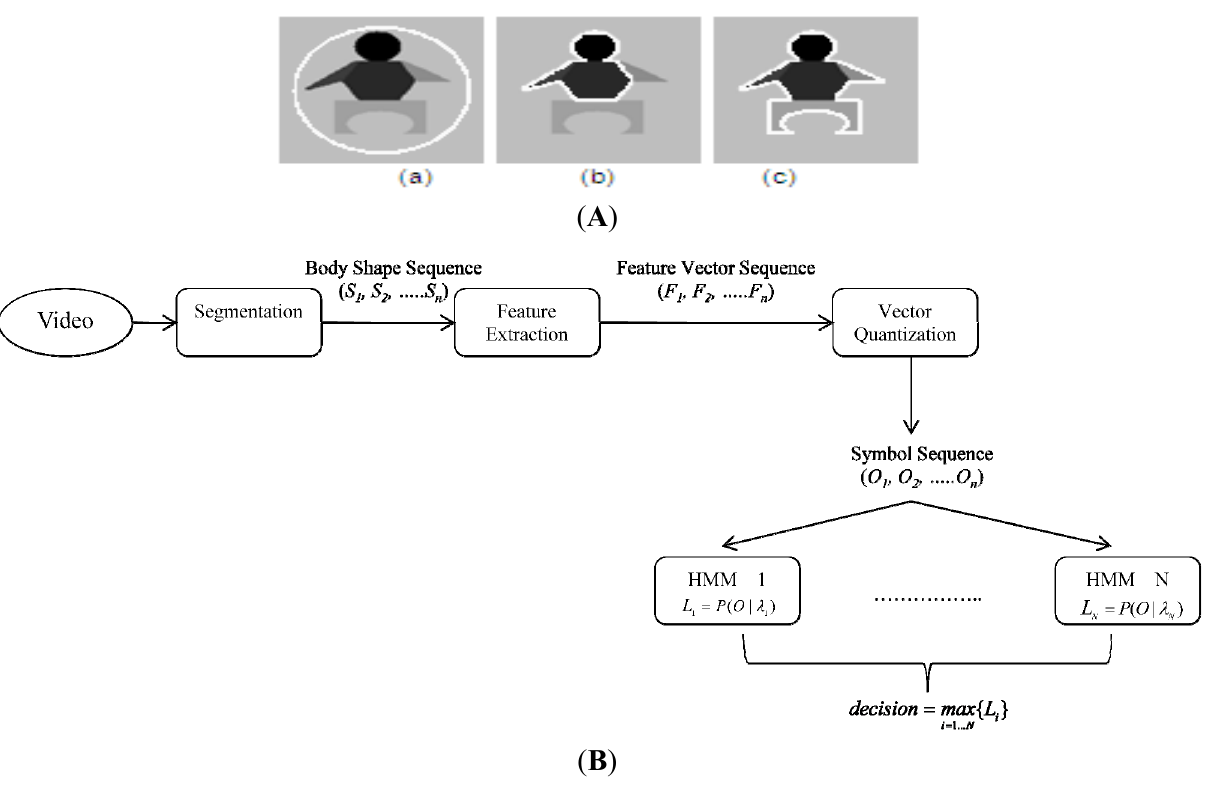
Table 1. Recognition rates with average accuracy = 91.4%. The value of blank cells is 0%.